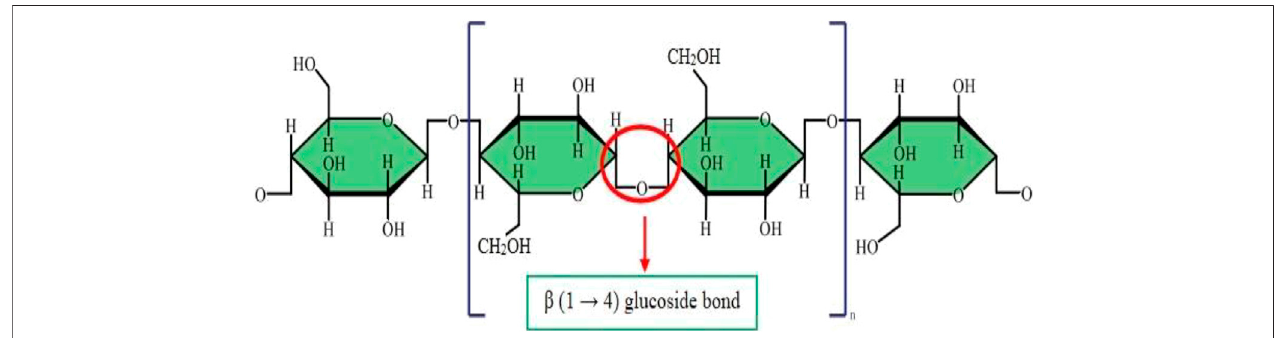
FIGURE 1 | Molecular structure of